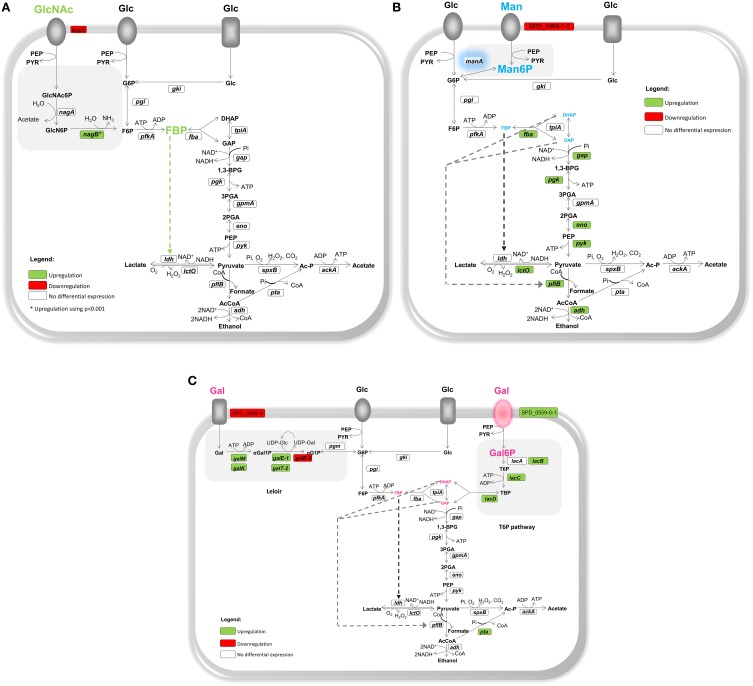
Schematic representation of the model illustrating the physiological response of S. pneumoniae grown on glycan-derived sugars. Transcriptional and metabolic changes in presence of (A) N-acetylglucosamine (GlcNAc), (B) mannose (Man), and (C) galactose (Gal) as compared to glucose (Glc) are shown. Target genes were those of central metabolism, glycolysis, and fermentation (pyruvate metabolism), and those encoding specific enzymes of glycan-derived catabolic pathways (transporters and catabolism). Gene annotations downloaded from NCBI, and intermediates are as in Figure 1. Sugar transporters depicted as ovoids and rectangles generically represent phosphoenolpyruvate phosphotransferase systems or ABC transporters, respectively. Green, red, and white boxes indicate upregulation, downregulation and no differential gene expression in glycan-derived grown cells as compared to Glc. * Upregulation using a less restrictive microarrays criterion (p < 0.001). Highlighted in green, blue, and pink are the glycolytic and/or sugar-specific catabolic intermediates detected by in vivo
13C-NMR in presence of GlcNAc, Man and Gal, respectively. The size of the font is indicative of the pool size of the intermediates (glycolytic or sugar-specific) accumulated in resting cells as determined by in vivo
13C-NMR. Big bold font indicates high accumulation whereas small size font is indicative of low amounts. DHAP and GAP are not detected by in vivo
13C-NMR but low accumulation in Man and Gal-grown cells, as compared to Glc-grown cells, is inferred due to the reversibility of the reactions catalyzed by FBP aldolase and triose 3-phosphate isomerase. Green dashed lines indicate positive metabolic regulation of enzymes. Dark gray dashed lines represent relief of LDH activation and light gray dashed lines represent relief of PFL inhibition. Blue shadow highlights a possible metabolic bottleneck in Man catabolism. Pink transporter highlights a possible bottleneck in Gal catabolism.